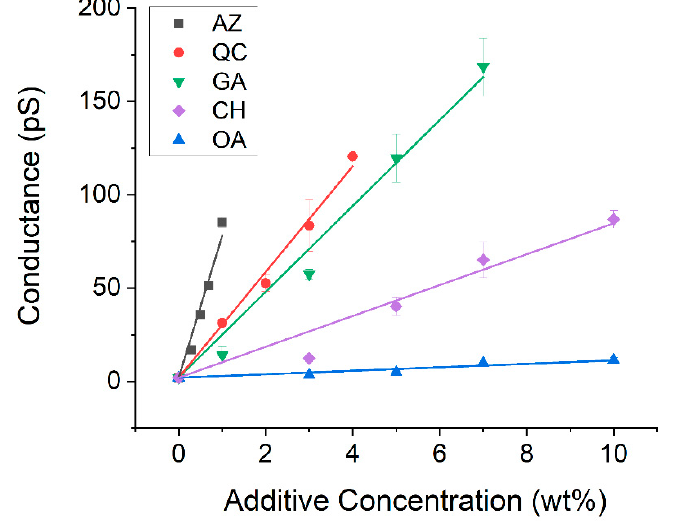
Figure 5. Conductance of PCL with various additives. The error bars indicate the standard deviation of three independent